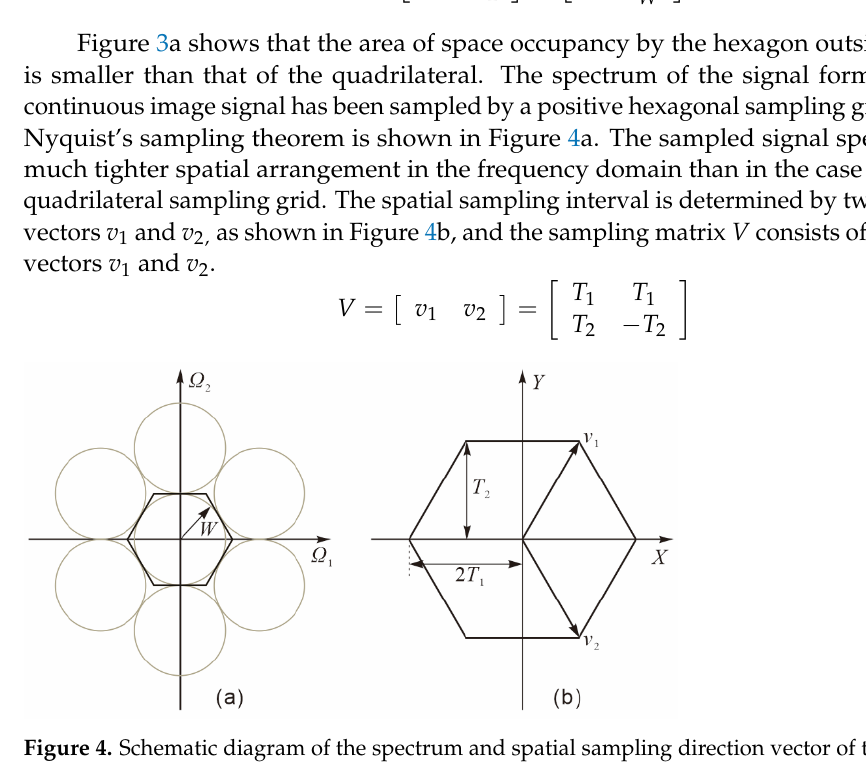
Figure 3. The frequency spectrum of a continuous band-limited signal after passing through a regular quadrilateral sampling grid: ( a ) spectrum of the original continuous signal and ( b ) fre- quency spectrum of the sampled signal.